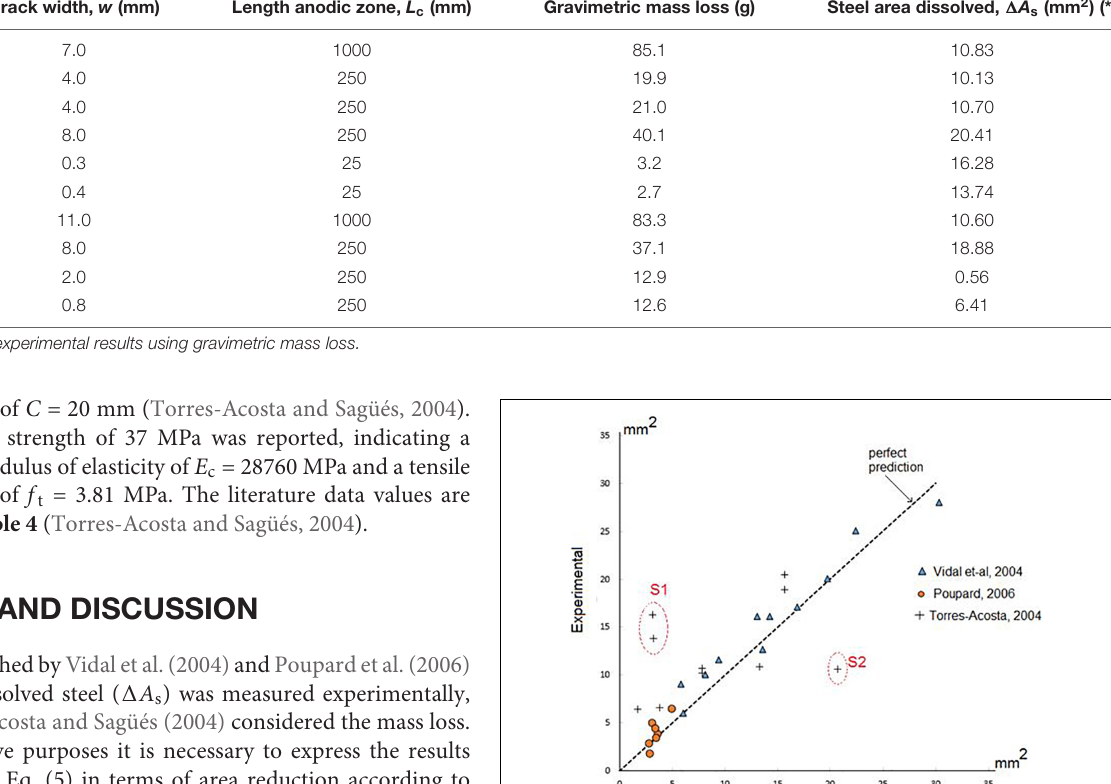
TABLE 4 | Experimental crack width values due to corrosion, calculated using data from the literature (Torres-Acosta and Sagüés, 2004). Sample